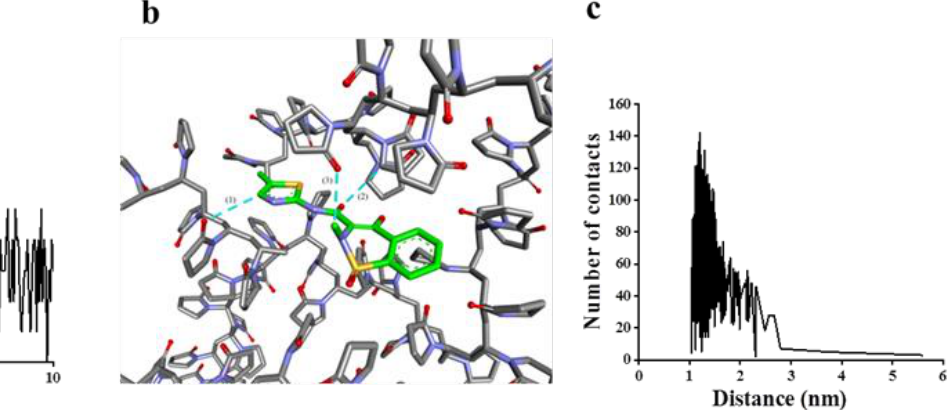
Figure 5. Hydrogen bonds and contact conditions between MLX and PVP-k17. ( a ) Distribution diagram of the number of hydrogen bonds; ( b ) the hydrogen bond formed in the system; ( c ) average number of contacts between MLX and PVP-k17 in the range of 0–6